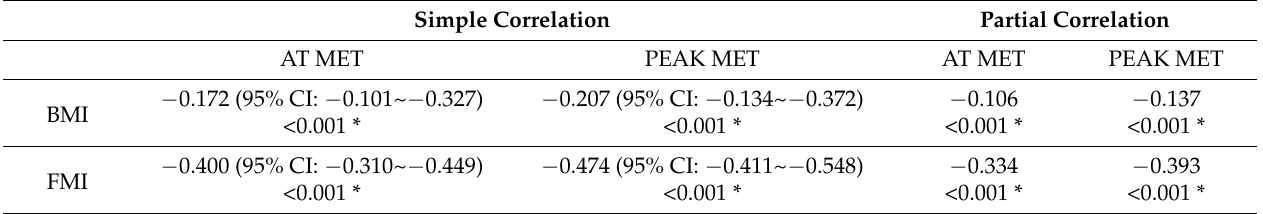
Table 4. Correlation between body mass index, fat mass index, and performance of exercise test of children and adolescents. Simple Correlation Partial